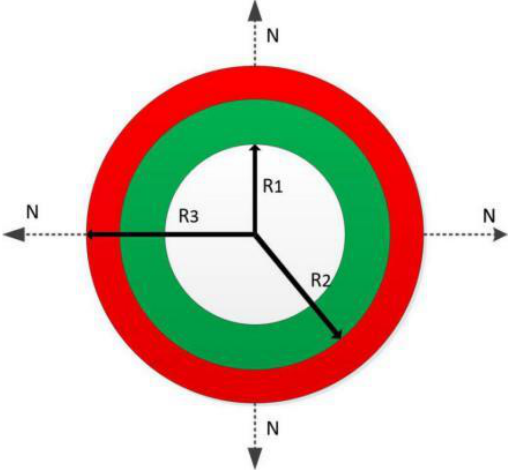
Figure 2. Schematic diagram of multi-layer vessel-like structure construction.